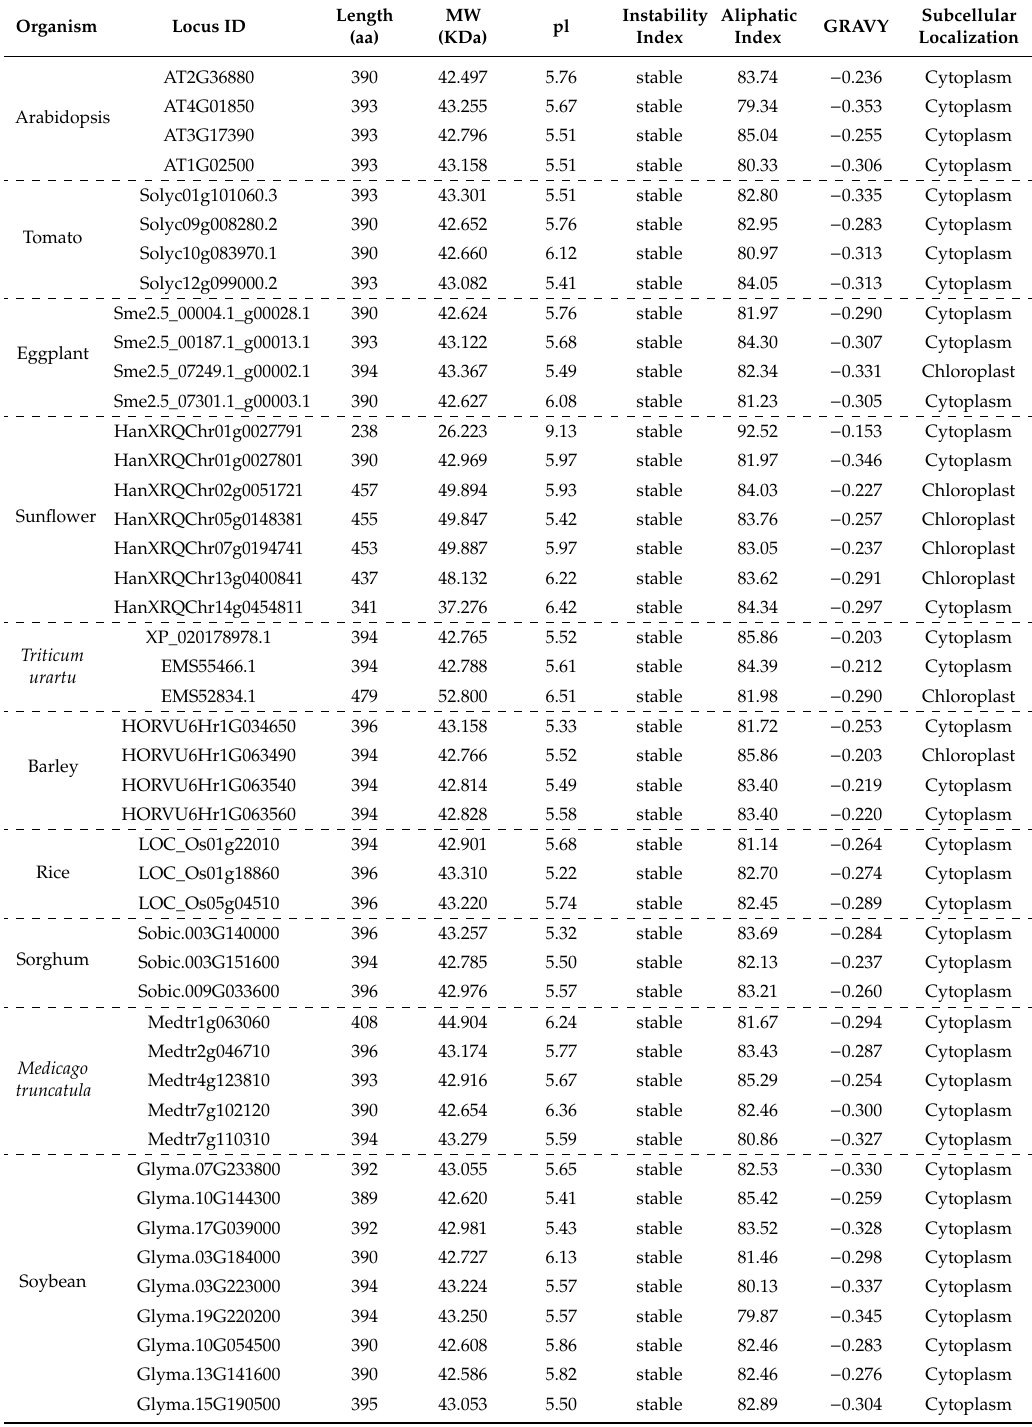
Table 1. The properties of SAMS genes in the studied